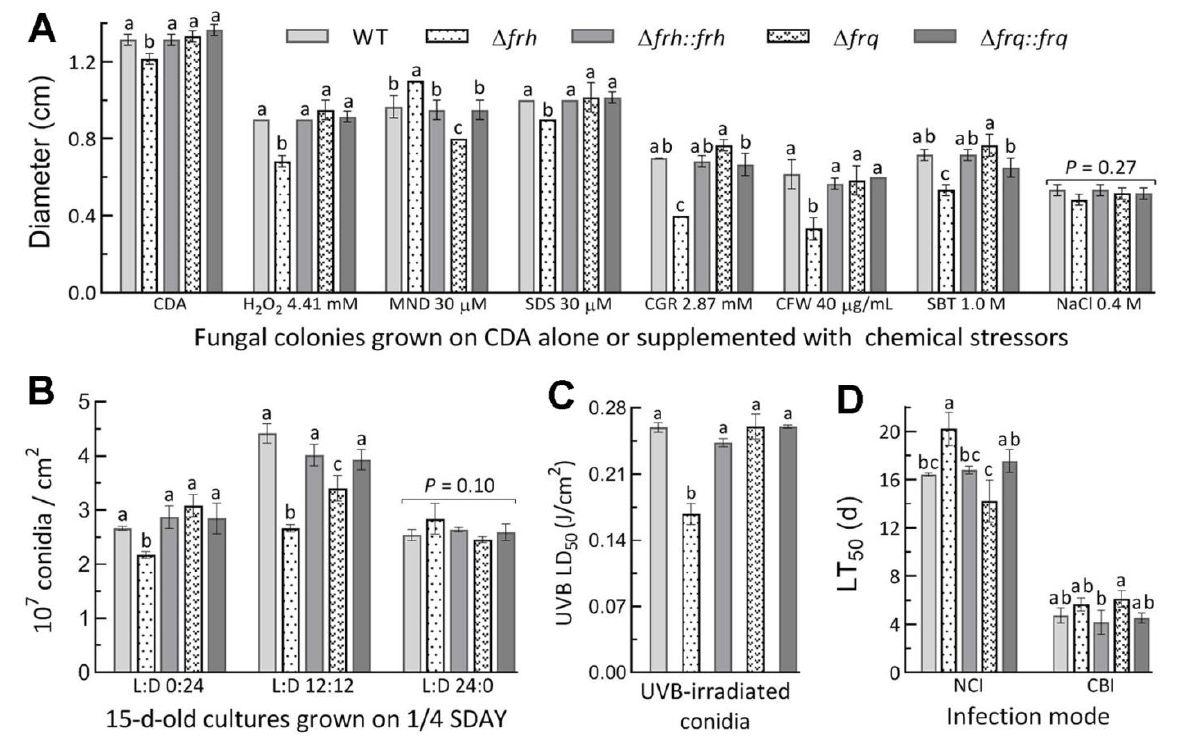
Figure 5. Effects of frq and frh knockout mutations on phenotypes associated with the lifecycle of M. robertsii . ( A ) Diameters of fungal colonies incubated at 25 °C on CDA plates alone or supplemented with indicated concentrations of chemical stressors (MND, menadione; SDS, sodium dodecyl sulfate; CGR, Congo red; CFW, calcofluor white; SBT, sorbitol). Each colony was initiated with 10 3 conidia. ( B ) Conidial yields measured from the 15 d-old cultures at 25 °C in the indicated L:D cycles. ( C ) The estimates of median lethal dose (LD 50 ) for conidial resistance to UVB irradiation. ( D ) The LT 50 estimates for the knockout and control strains against G. mellonella larvae inoculated by topical application of a 10 7 conidia/mL for normal cuticle infection (NCI) or intrahemocoel injection of ~500 conidia per larva for cuticle-bypassing infection (CBI). Different lowercase letters in each bar group denote significant differences ( p < 0.05 in Tukey’s HSD tests). Error bars: SDs of the means from three independent replicates.